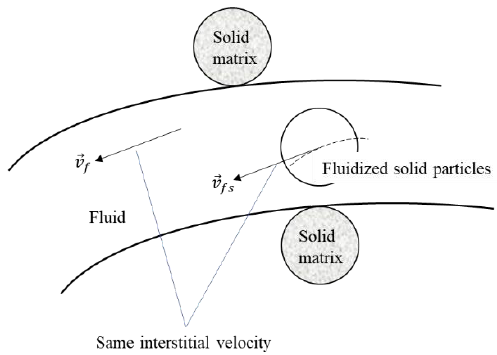
Figure 3. Pore channel with fluidized solid particles.